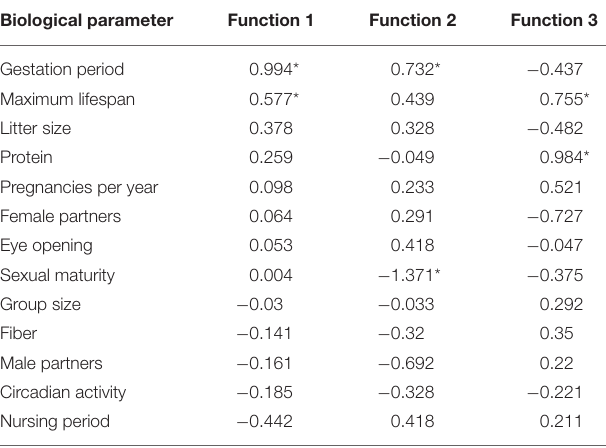
TABLE 4 | Standardized canonic discriminant function coefficient for the significant discriminant functions 1–3 (Table 3) of the biological